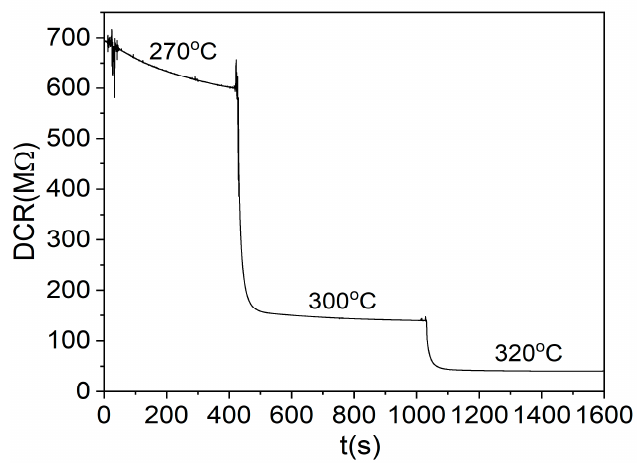
Figure 13. Dependence of the DC resistance of the TCOx sensor on temperature at 30% O 2 volumetric concentration for the TiCe-0.5:0.5-40 sample.